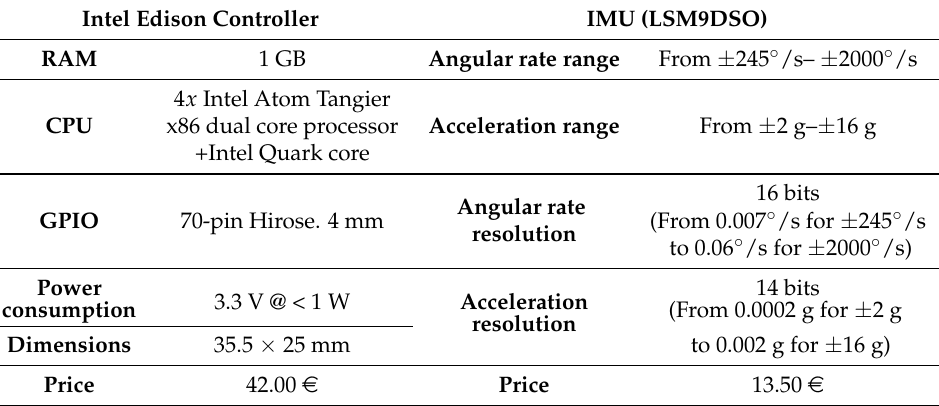
Table 3. Technical specifications of hardware elements included in the Intel Edison